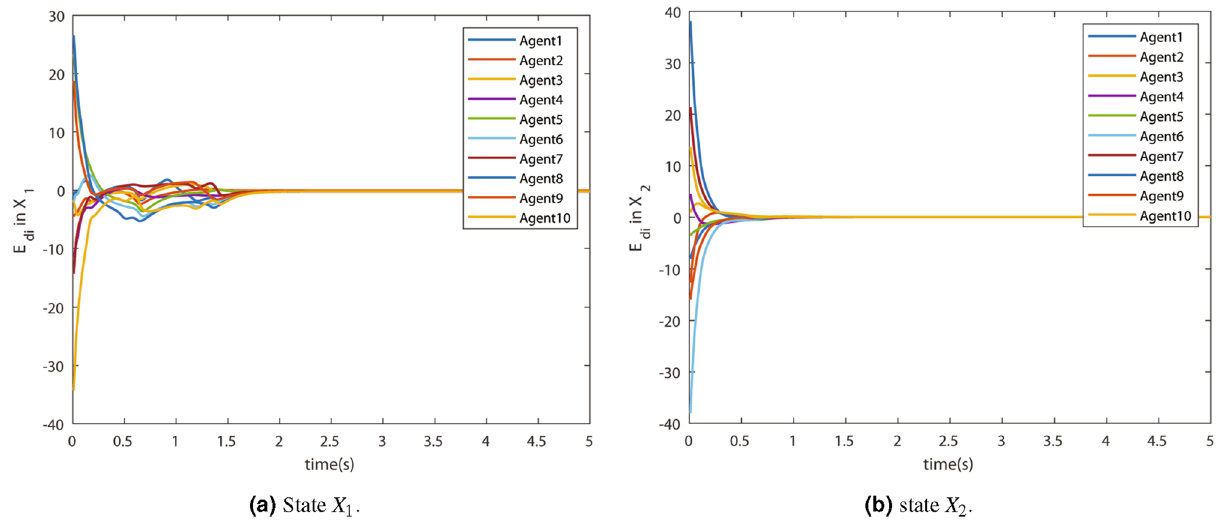
Figure 7. Consensus error E di .